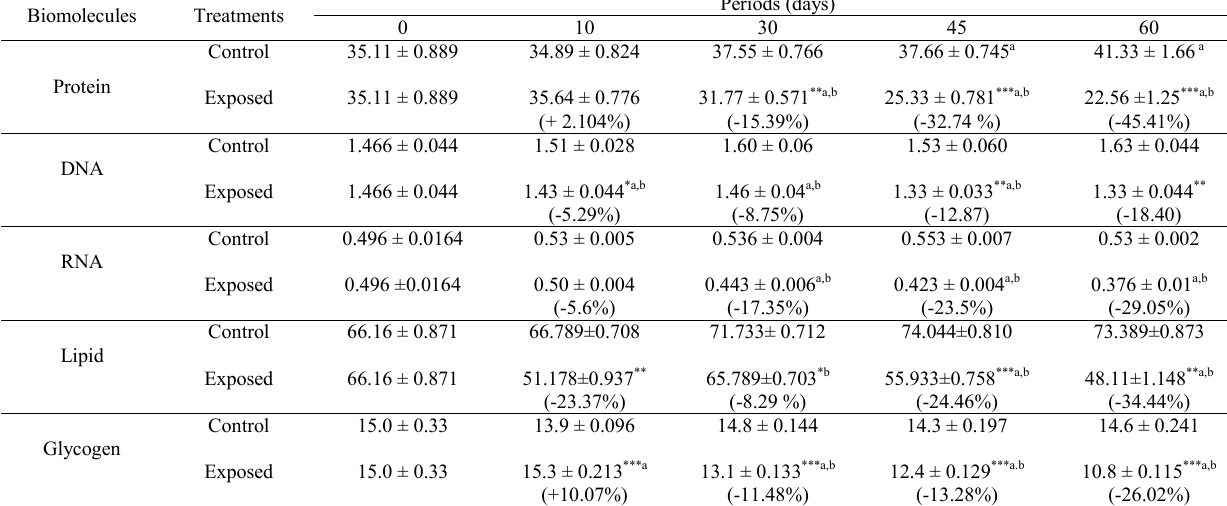
Table 4. Fluctuations in different biomolecules in the brain of Clarias batrachus , at different period of exposure to 1 mg/L of sodium arsenite. Protein, DNA, RNA, lipid, and glycogen were expressed in mg/gm wet wt of tissue. Data are shown as mean ± SEM (n = 9). (%) Denote changes over respective controls. Two way ANOVA followed by Dunnett’s t -test. The criterion for significance differences set at ( * ) p <0.05, ( ** ) p <0.01 and ( *** ) p <0.001 with respective control. ( a ) Indicates when exposed groups were compared with 0 day controls and ( b ), when exposed groups were compared with previous exposed